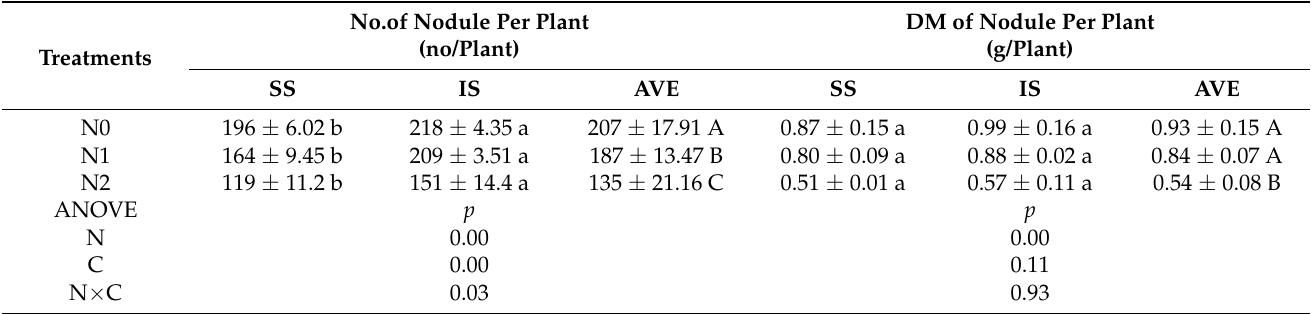
DM of Nodule Per